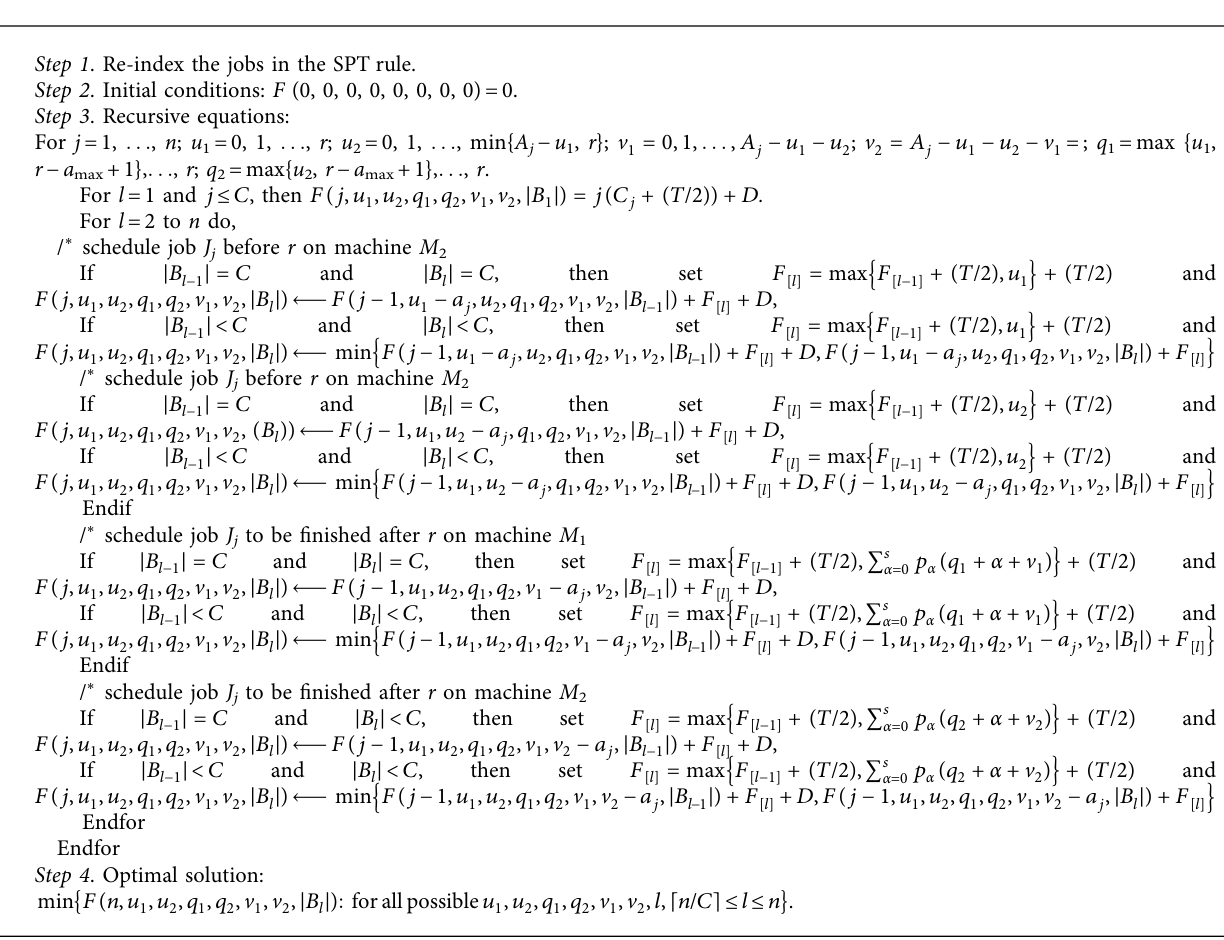
A LGORITHM 4: Algorithm